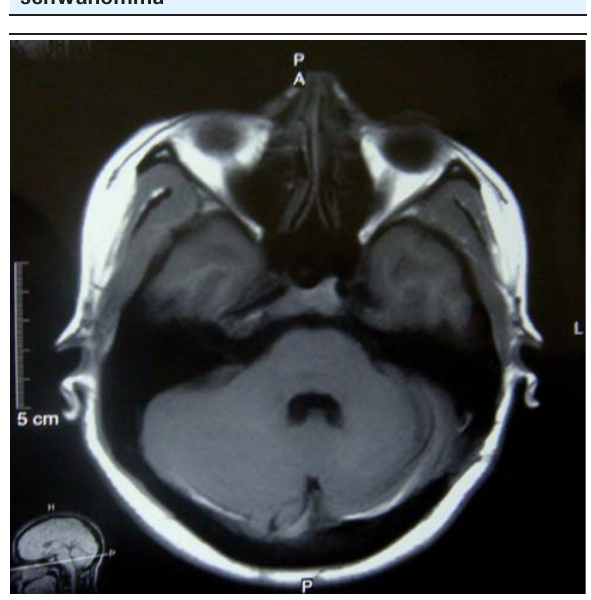
Figure 2. Contrast enhanced axial T1 weighted MRI scan displaying left cerebellopontine angle vestibular schwanomma